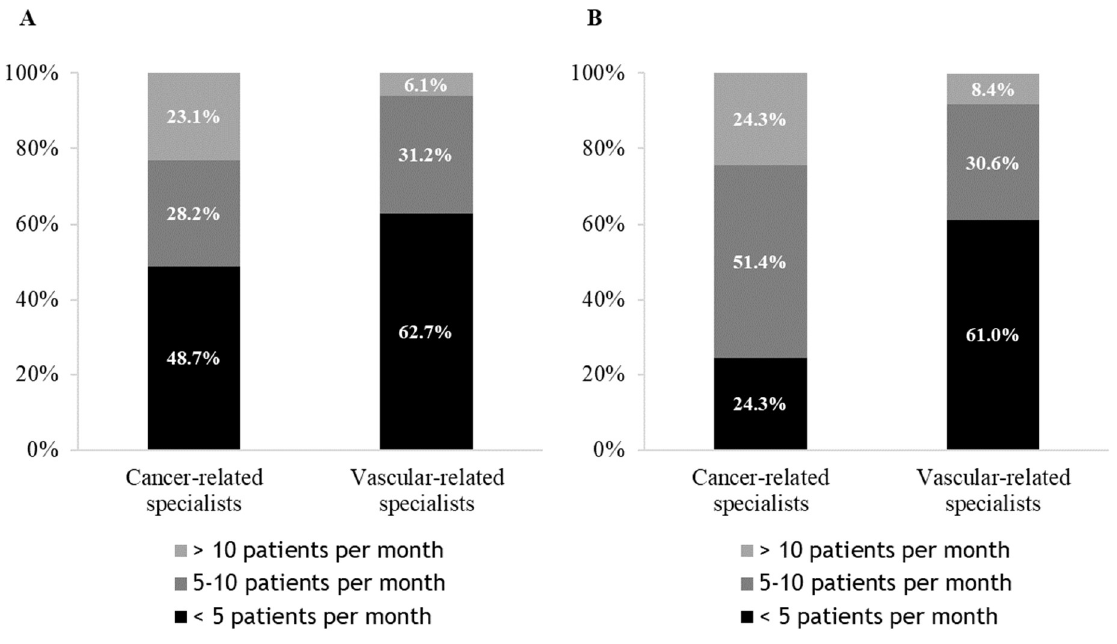
Figure 1. Prescription of curative treatment for cancer-associated venous thromboembolism